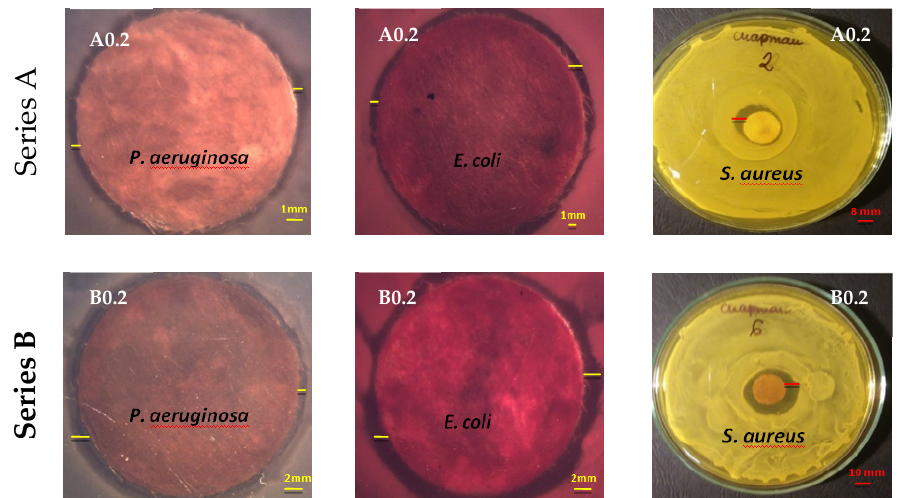
Figure 13. Representative images of the agar plates showing the diameter of the inhibition zone for P. aeruginosa , E. coli and S.aureus .